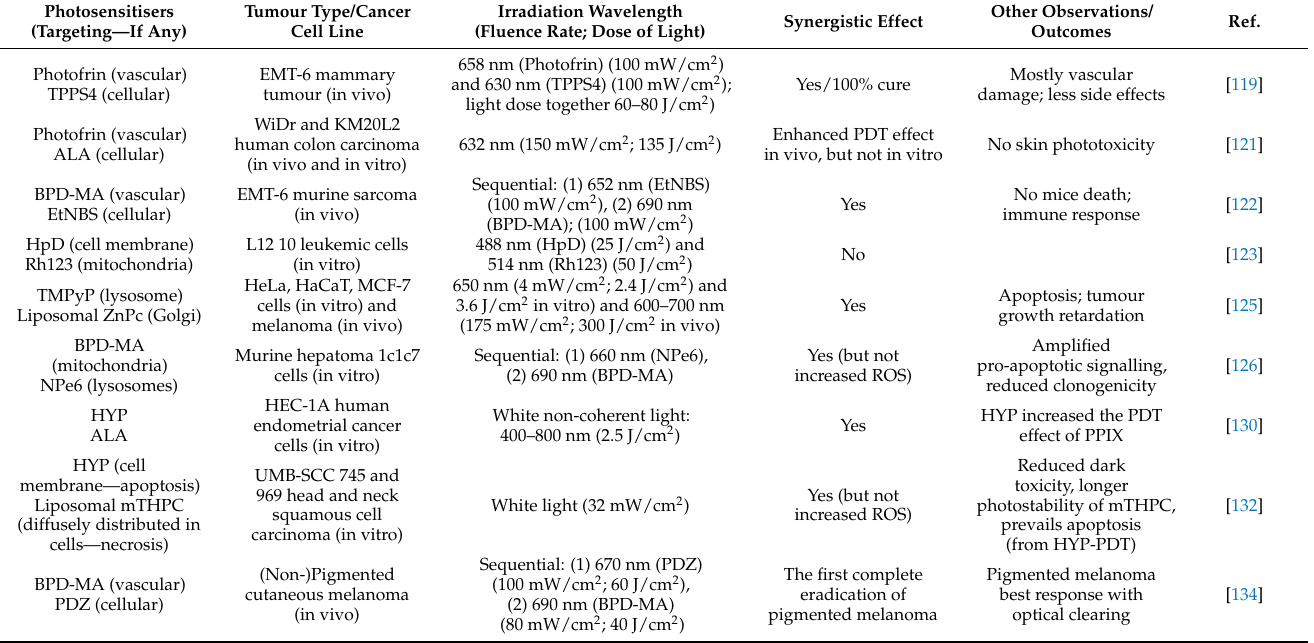
Table 1. Summary of the combinations of two PSs in PDT against cancer with representative